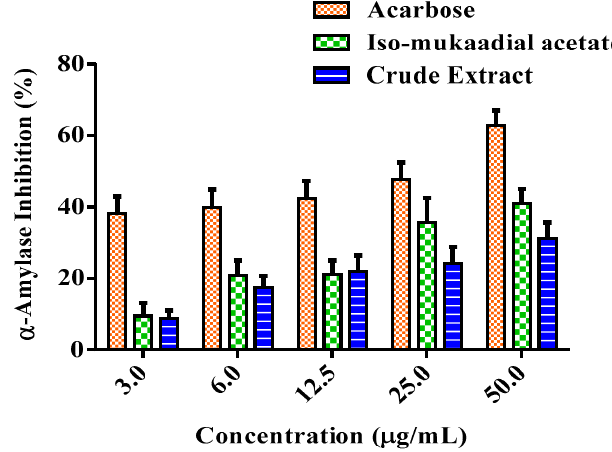
Figure 6. Percentage α -amylase inhibitory effect of a standard compound of acarbose, iso-mukaadial, and crude extract. Values are presented as means, and vertical bars indicate SEM, p < 0.05.